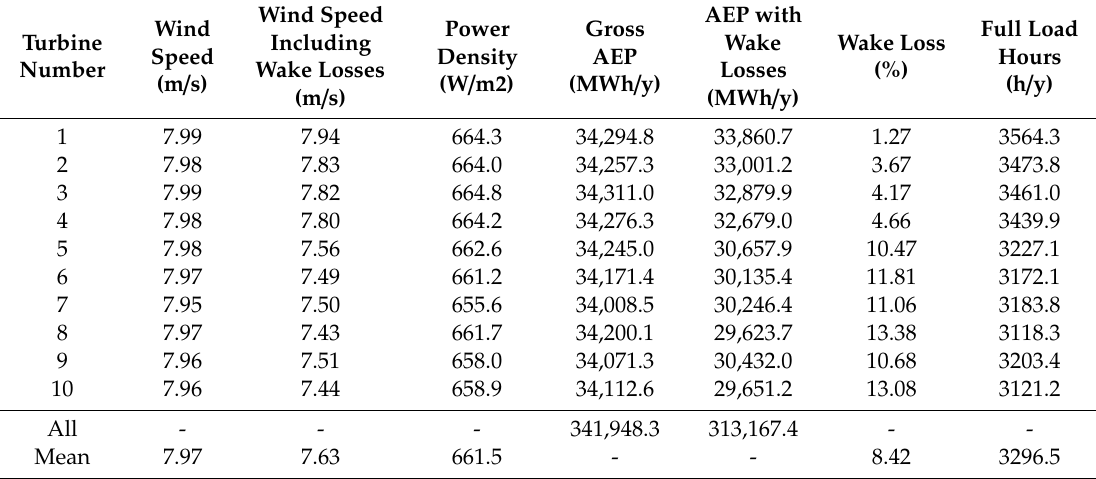
Table 9. Estimated power generation of the wind farm according to WindSim and MCP with data from the mast and MERRA. The assigned turbine numbers are the same as those in Figure 9.